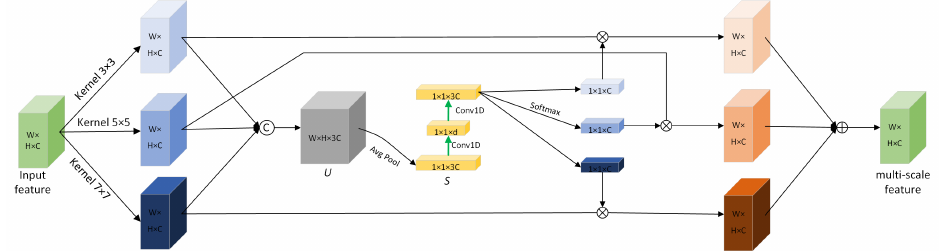
Figure 3. Illustration of